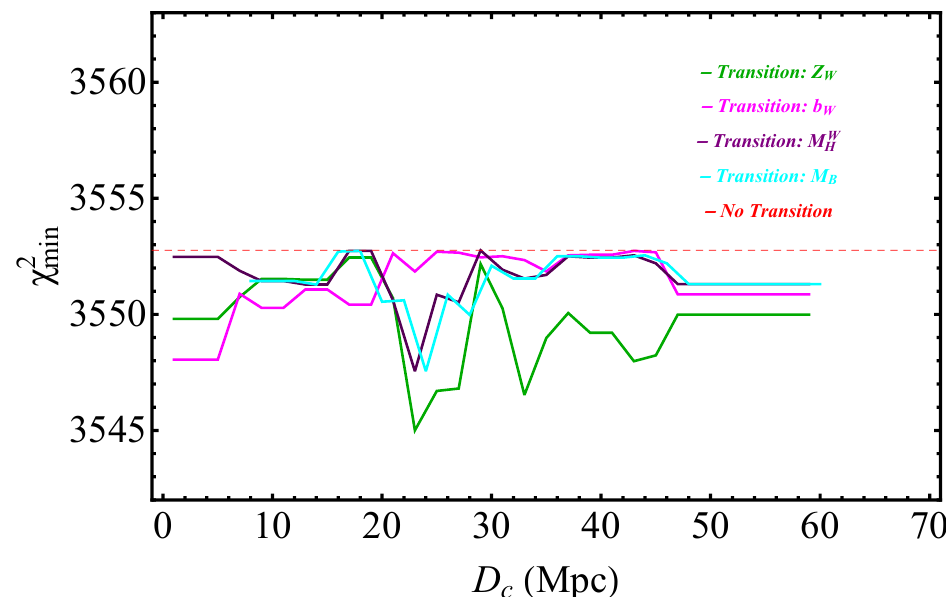
Figure 12. The values of ∆ χ 2 in terms of D c for the four transition models considered with respect min to the SH0ES baseline model. No inverse distance ladder constraint on M B is used for either the baseline or the transition models. The small improvement of the fit to the data is not enough to justify any model